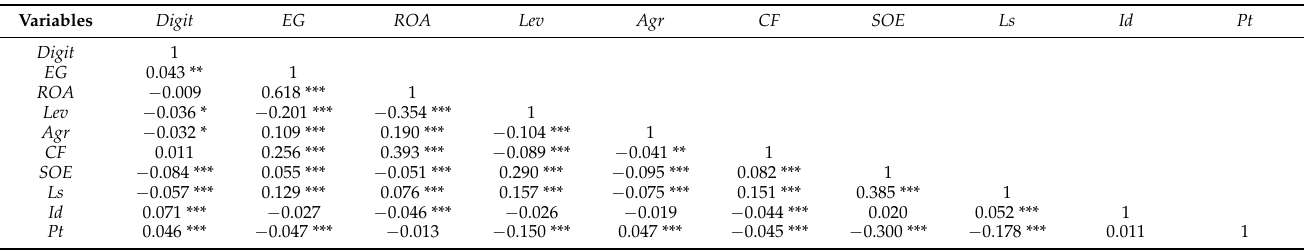
Table 3. Pearson correlation analysis.